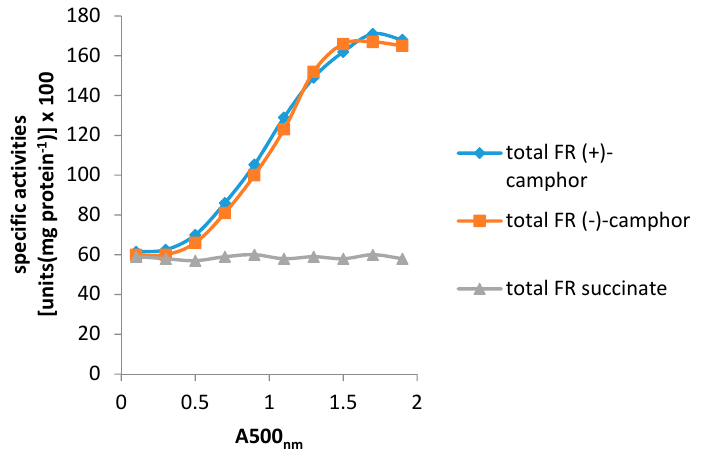
Figure 5. Specific activity of total flavin reductase (FR) throughout the growth of P. putida ATCC 17543 on either (+)-camphor, ( − )-camphor or succinate as sole carbon source.